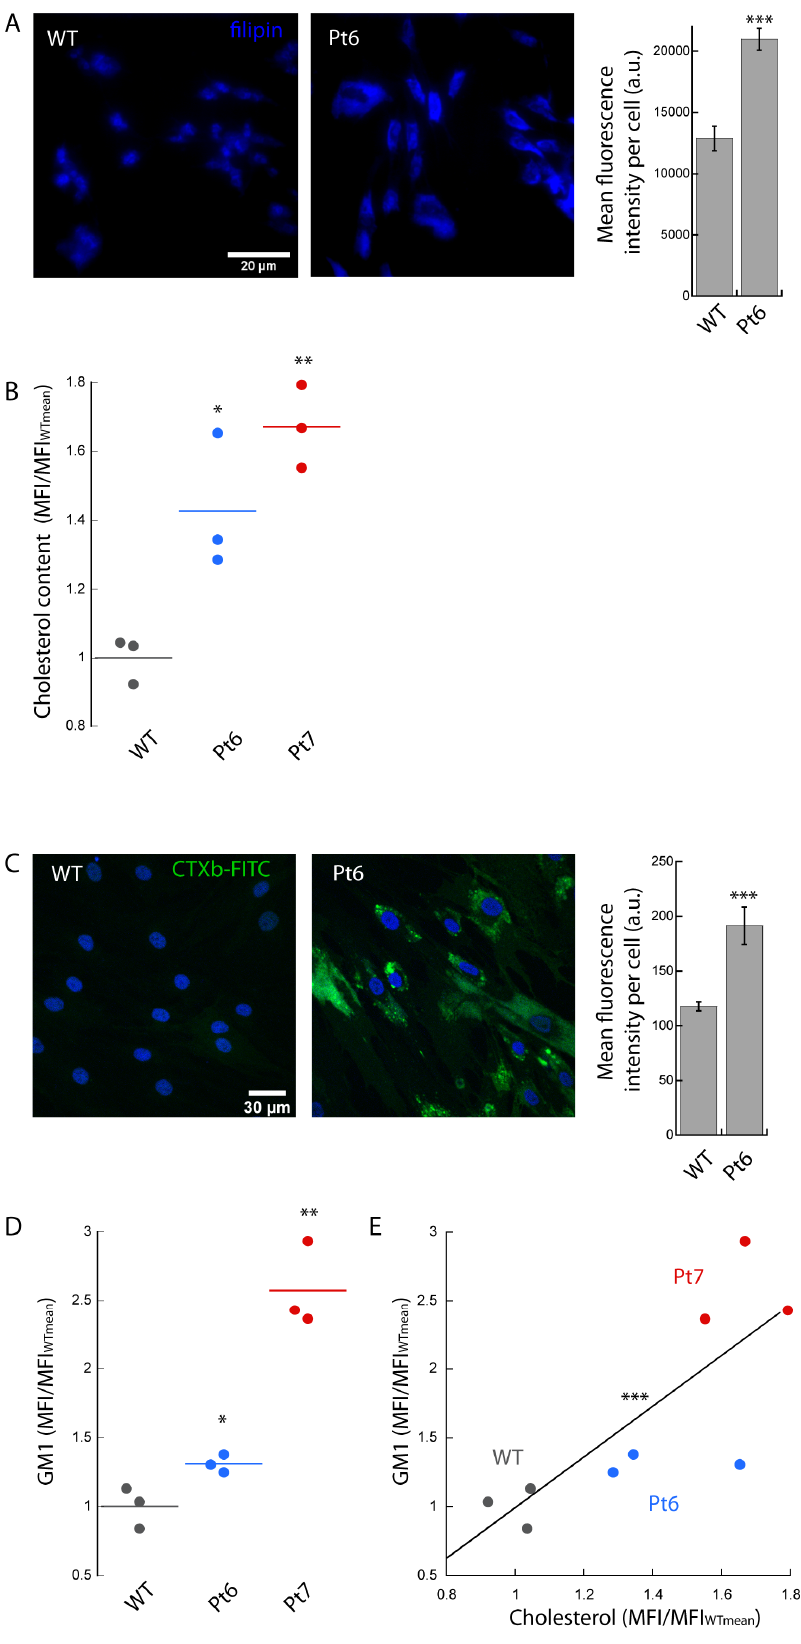
Figure 3. Type C Niemann–Pick disease. Thawed primary cultures of fibroblasts isolated from control and NPC patients (Pt6 and Pt7) were cultured, fixed, permeabilized, labeled with Filipin III ( A , B )